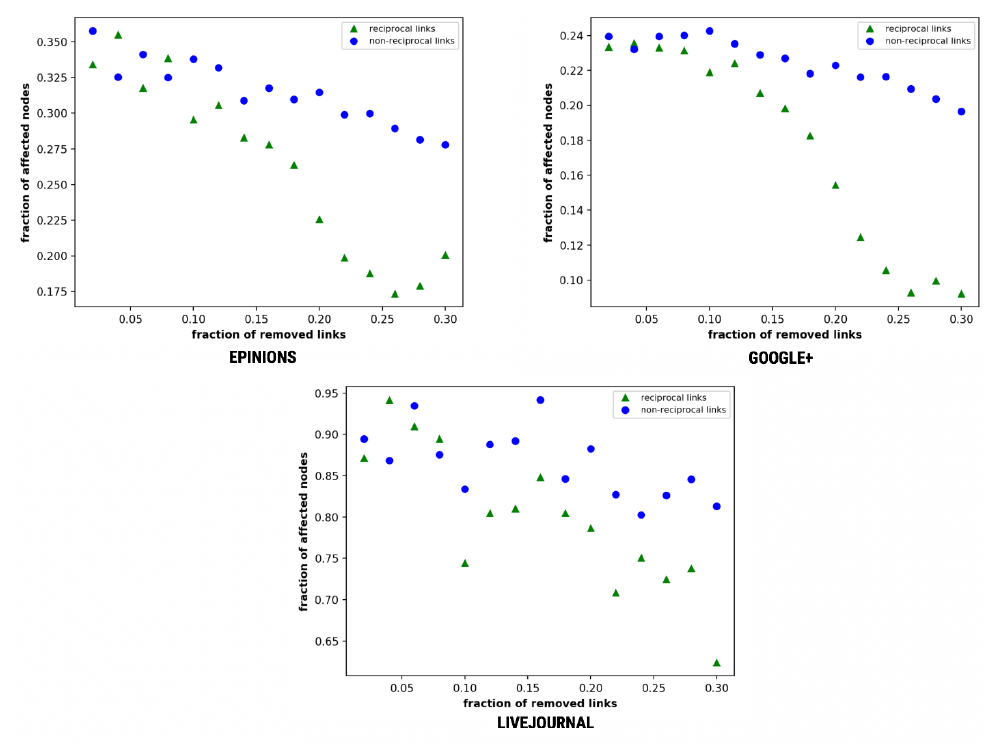
Figure 7. Weighted diffusion—fraction of affected nodes as a function of the fraction of removed links.